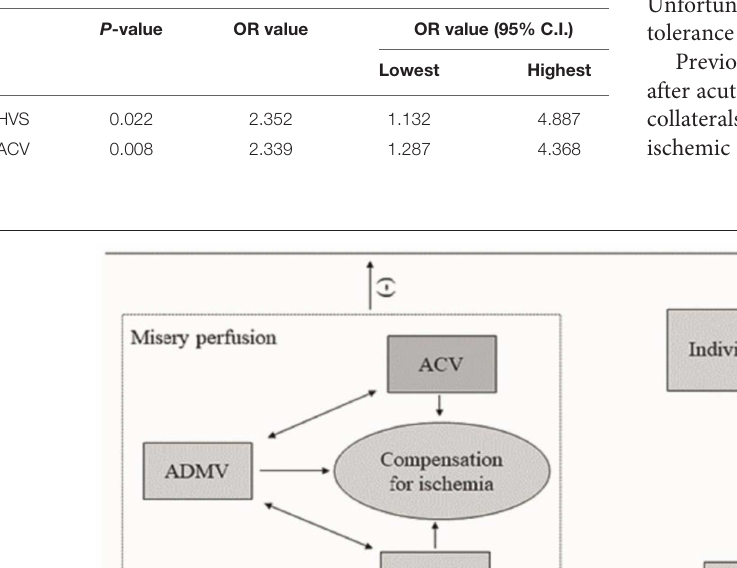
Frontiers in Neurology |